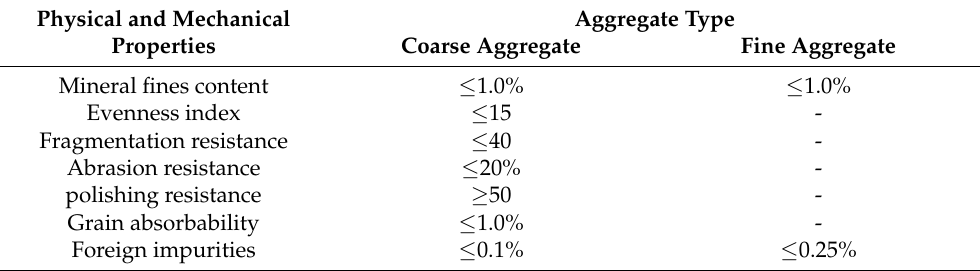
Table 2. Polish requirements for aggregates intended for airfield